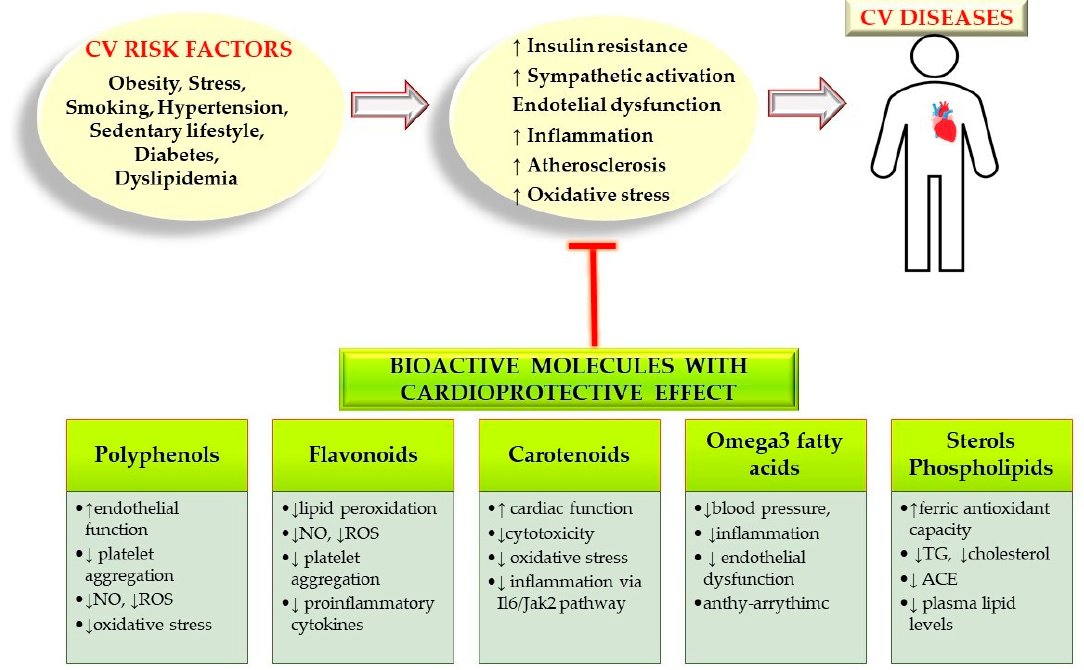
Schematic overview of CV risk factors, pathophysiology of CV diseases and the cardioprotective mechanisms and effects of plant-food derived bioactive compounds. Abbreviations : Cardiovascular (CV), Nitric oxide (NO), Reactive oxygen species (ROS), Interleukin-6 (IL-6), Janus tyrosine kinase 2(JAK2), Triglycerides (TG), Angiotensin-converting enzyme (ACE)